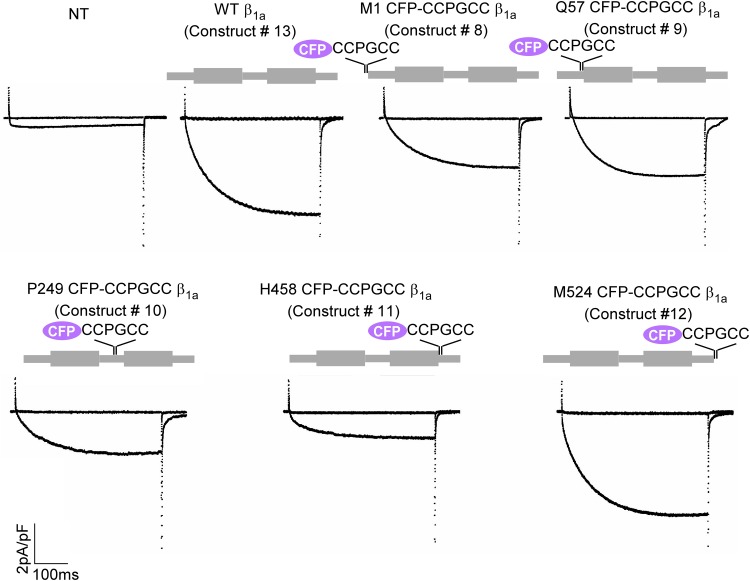
Representative Ca2+ current traces resulting from 200 ms test depolarizations to –30 mV and +30 mV in ß1 KO myotubes expressing wild-type ß1a (WT ß1a construct 13) and the ß1a CFP-CCPGCC concatemer constructs (constructs 8 to 13) used in Fig 2B–2F or non-transfected (NT) controls.